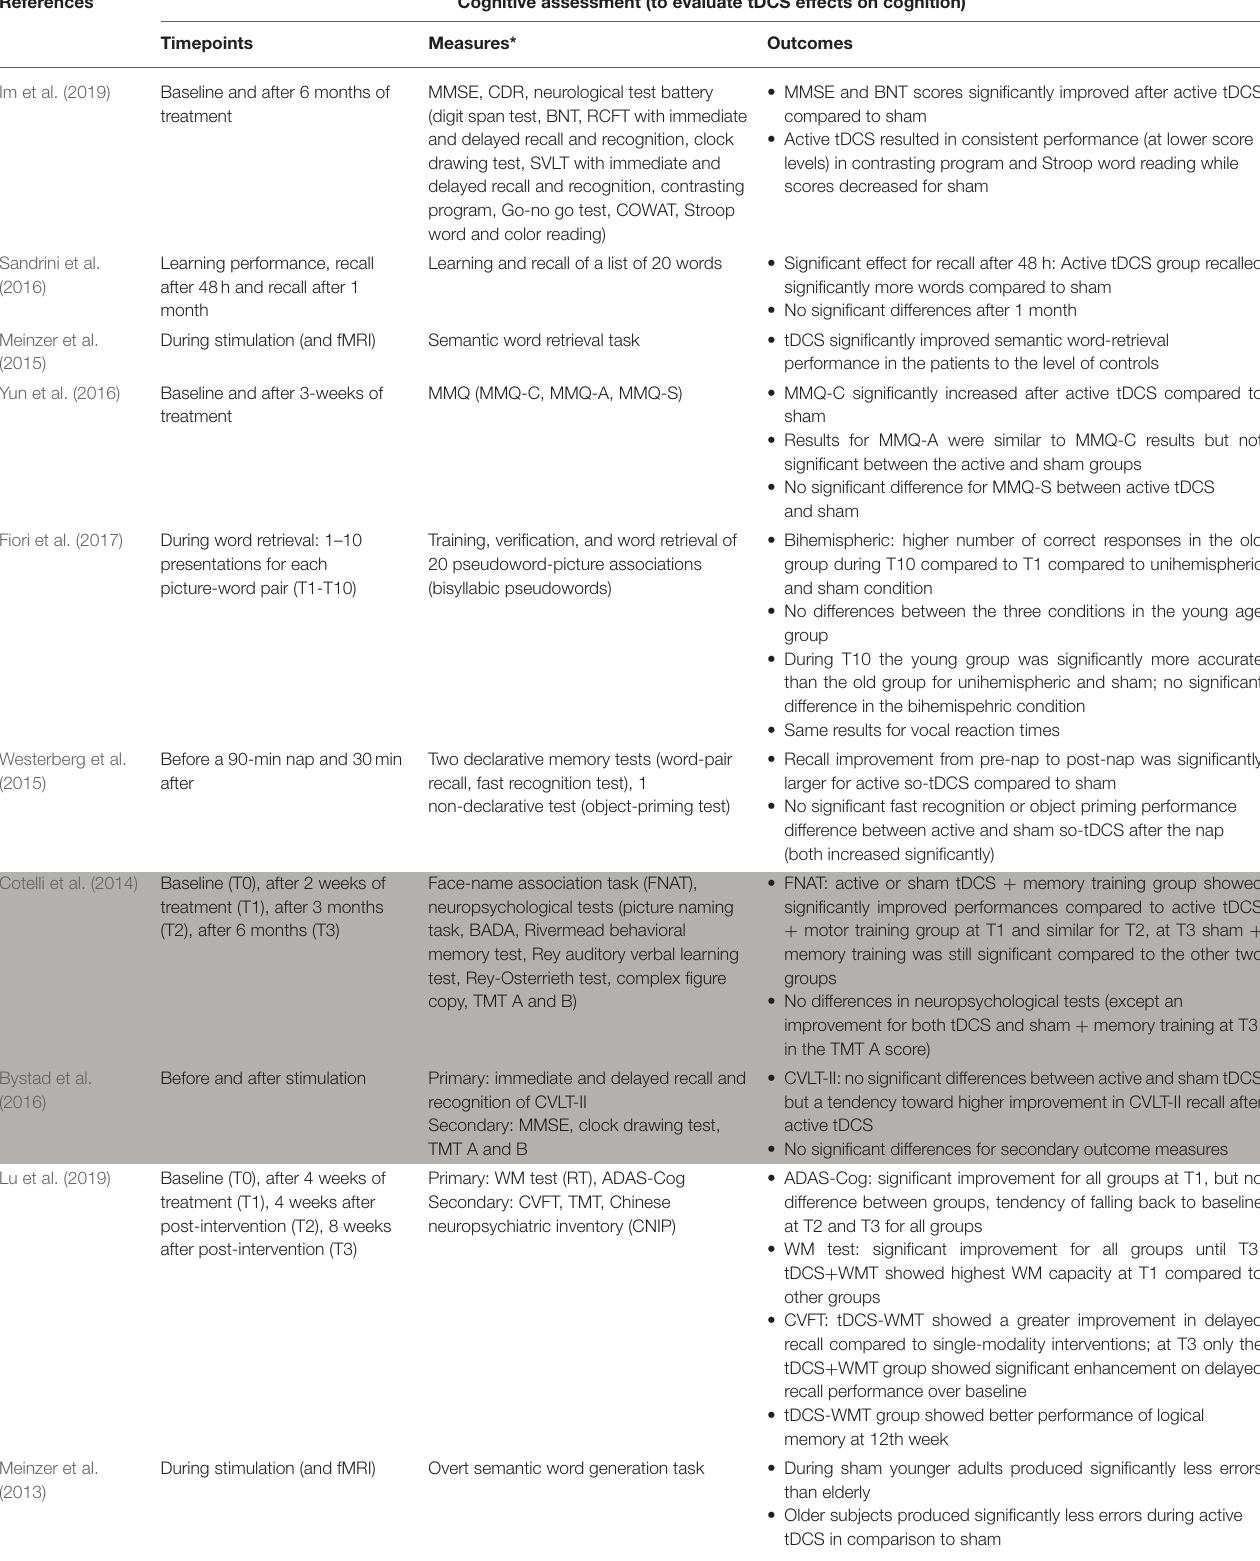
TABLE 3 | Summary of all studies reviewed, listing respective cognitive assessments including the timepoints of the assessment, exact measures, and main